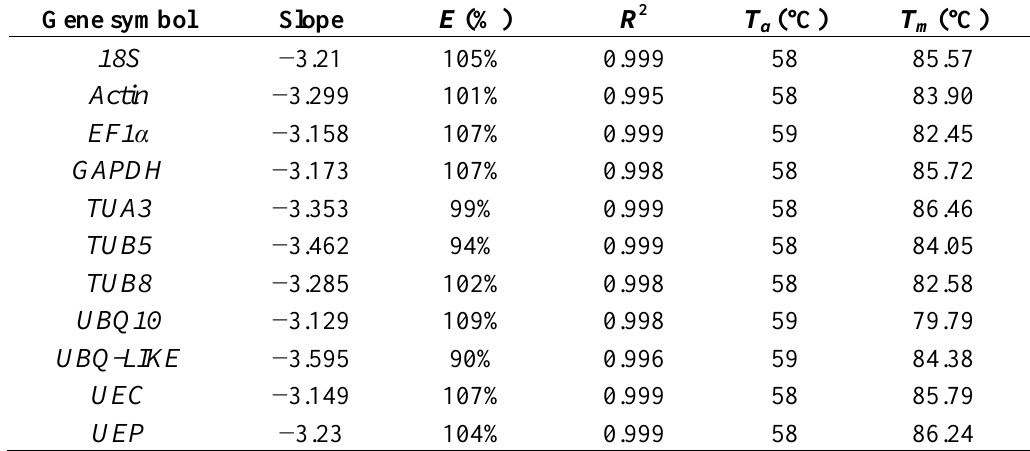
Table 1. Slopes, amplification efficiency ( E ), correlation coefficient ( R 2 ),